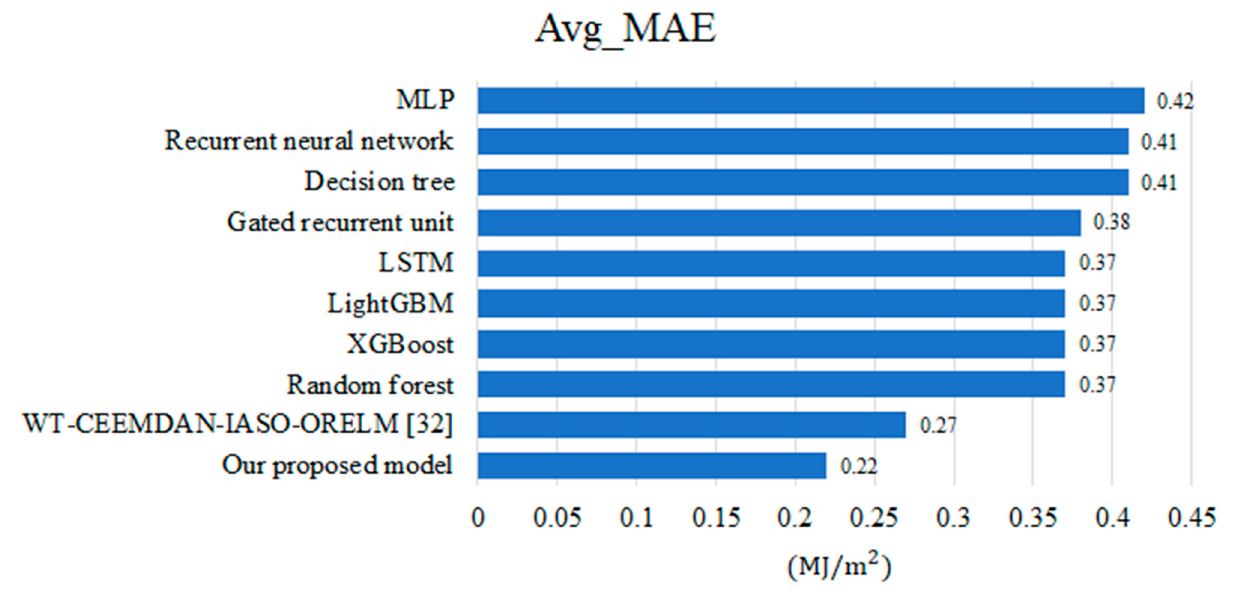
Figure 10. Average MAE comparison of solar radiation forecasting models (MJ/m 2 ).